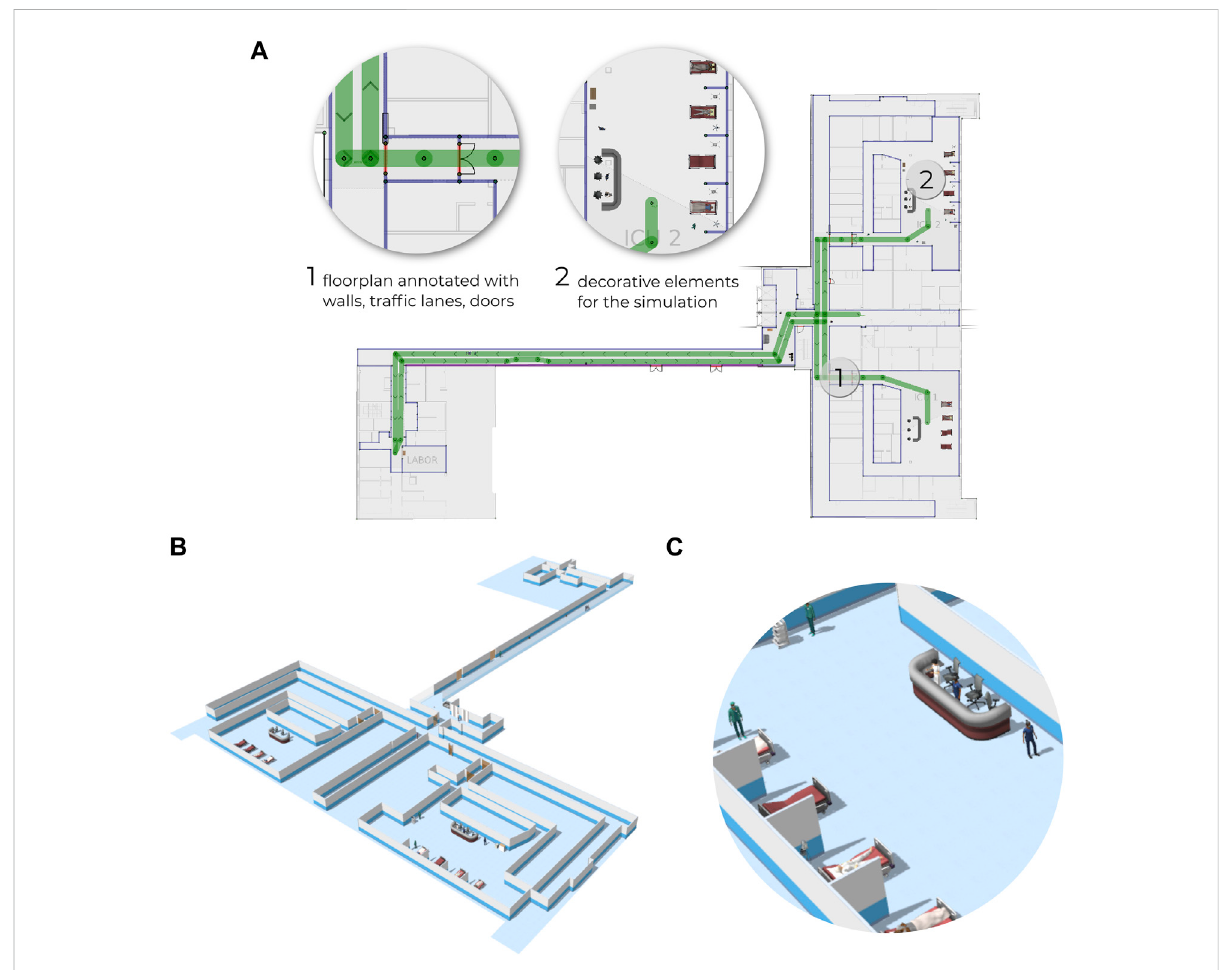
FIGURE 3 Hospital environment annotated via Traf fi c Editor (A) which is used to generate con fi guration fi les necessary for the RMF run-time and also to generate a simulated environment (B) containing furniture, people, etc (C)